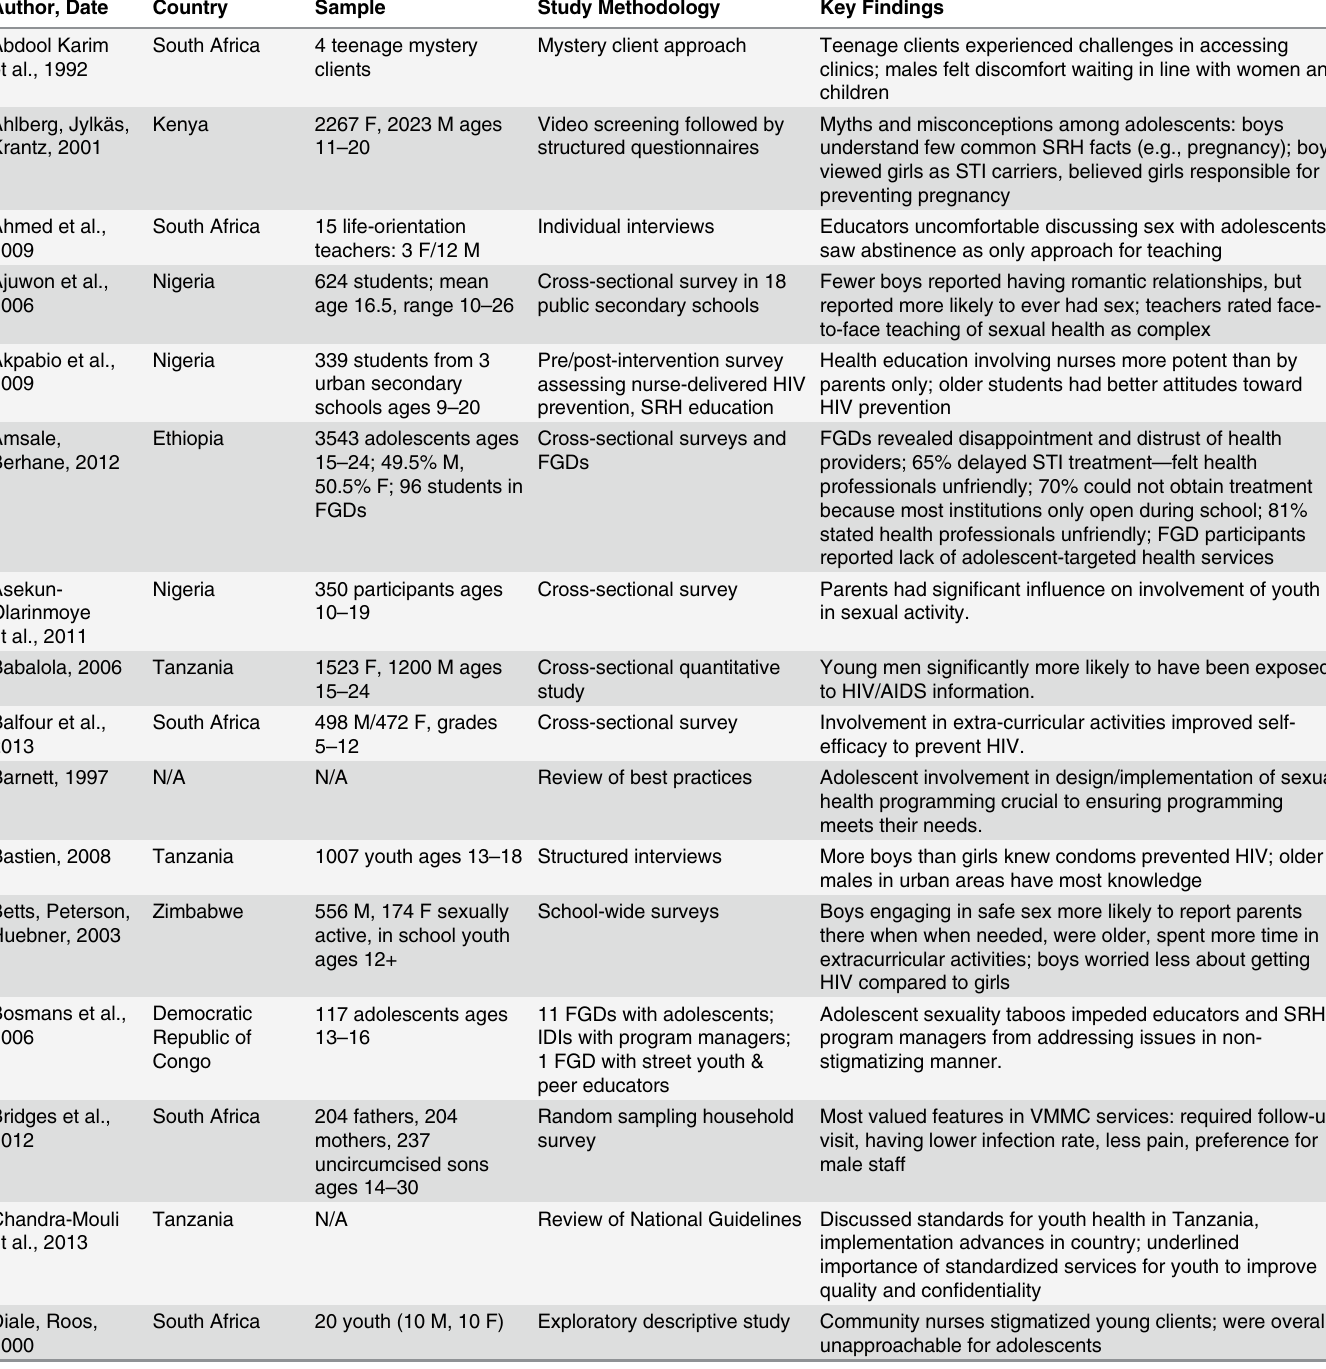
Table 2. Studies of Sexual and Reproductive Health and VMMC Service Seeking Behavior and Satisfaction Among Male Adolescents in Sub-Saha- ran